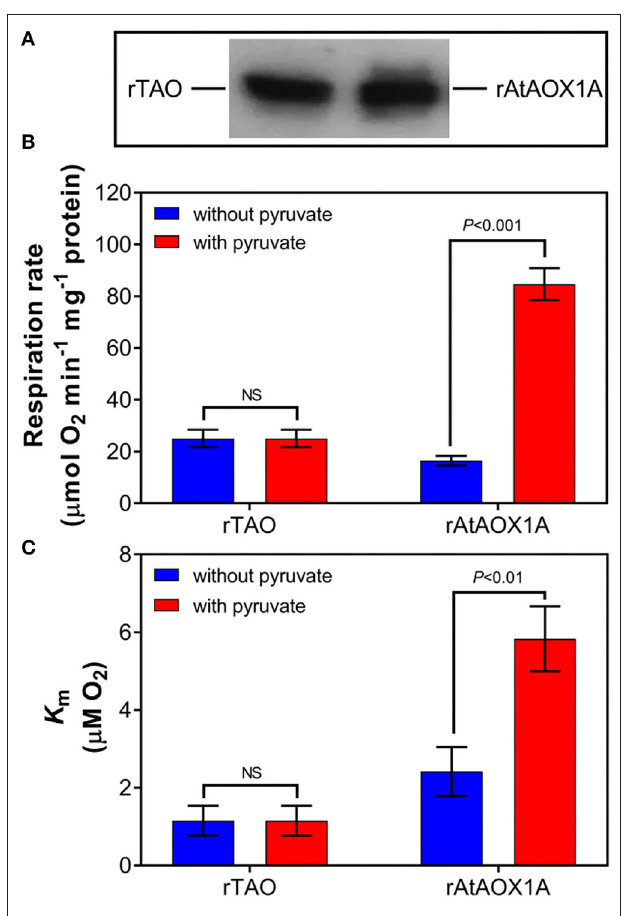
FIGURE 4 | Oxygen kinetic parameters of rTAO and rAtAOX1A. Membrane samples were run in 2ml of a MOPS buffer pH 7.5 with ( + ) or without (–) 10mM pyruvate, with 1.25mM NADH in an oxygen electrode (OROBOROS instrument). (A) Determination of the signal intensity of immunodecorated rTAO and rAtAOX1A by SDS–PAGE after separation of 20 µ g of total membrane proteins; the pixel intensities obtained by the Image J software and the relative protein concentrations were calculated based on the signal intensity of immunodecorated purified rTAO and rAtAOX1A. Respiration rate (B) and K m (C) for O 2 were measured and compared with or without pyruvate. Results are an average of at least three separate preparations. The significant difference p < 0.05 was marked as different letters. NS, not statistically